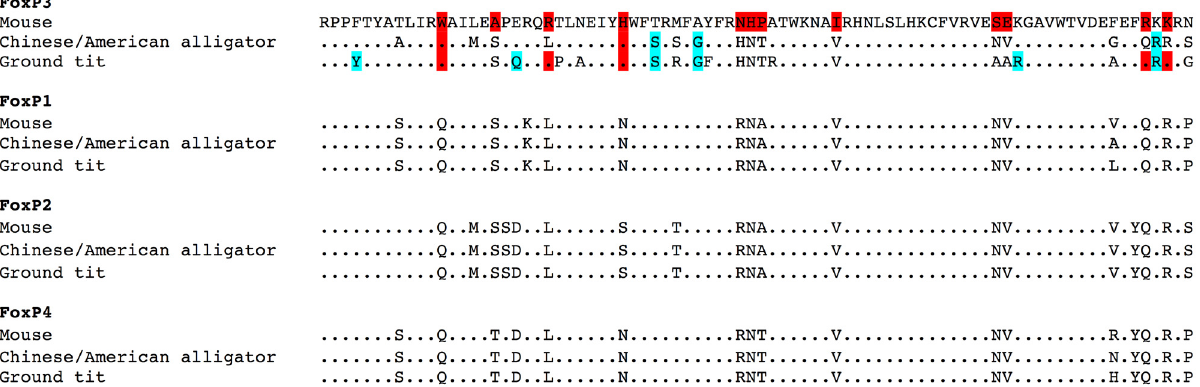
Fig 5. The distinct forkhead domain of FoxP3. The FoxP3 forkhead domain of the mouse, alligator and ground tit, aligned to FoxP1, FoxP2 and FoxP4 paralogues in the same species, demonstrating its divergent evolution and unique signature residues. The mouse FoxP3 sequence is used as the baseline sequence and only amino acids in other sequences that differ are